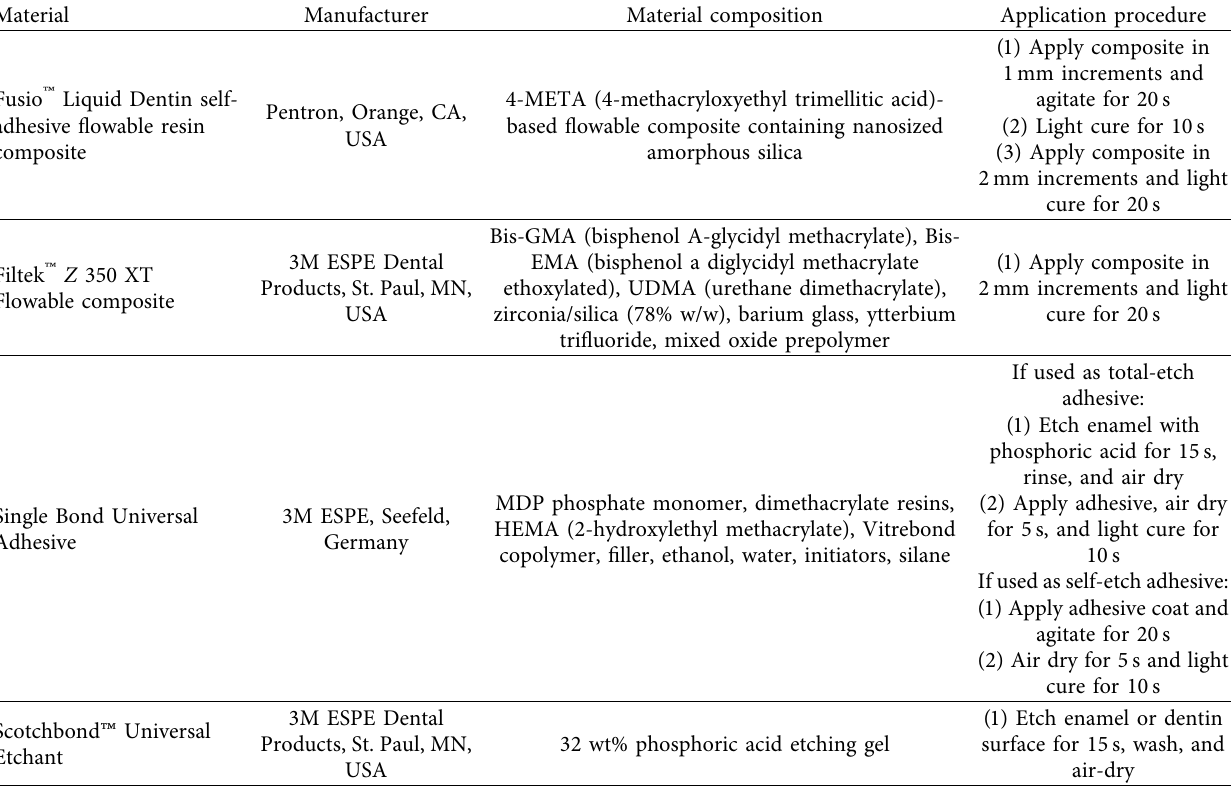
Table 1: Materials used in this study.